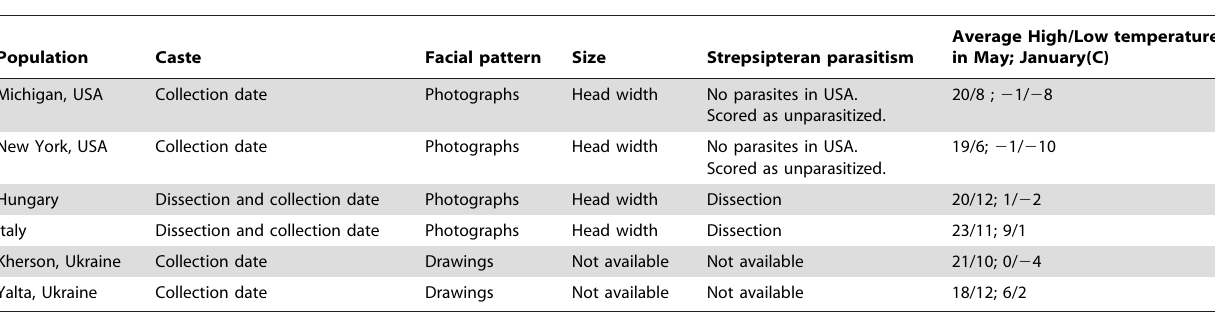
Table 1. Methods in each